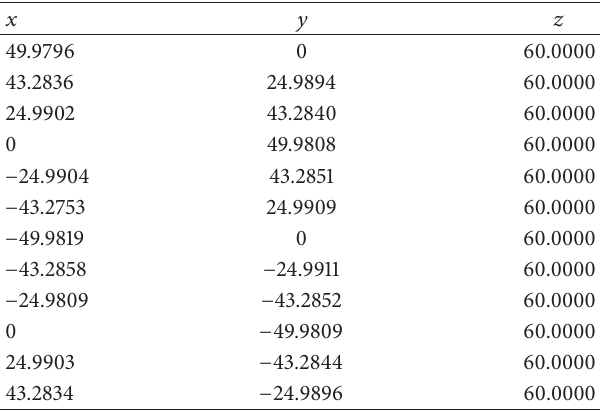
Figure 7: The measuring points fitting.